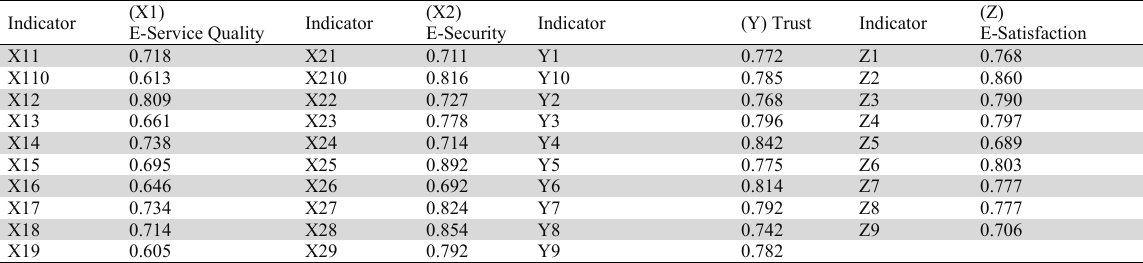
Outer loading test results